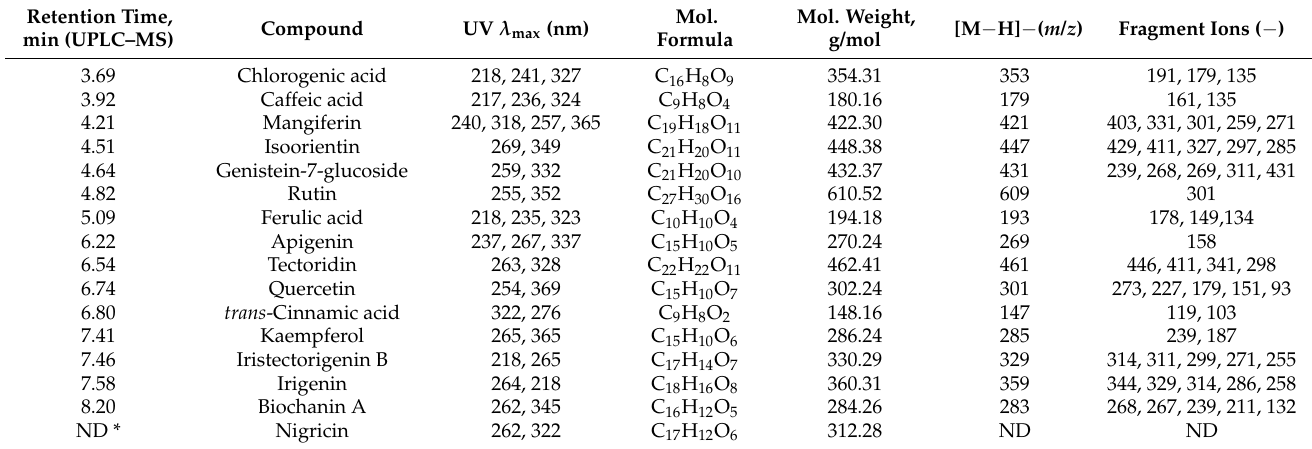
Table 2. Chromatographic, UV, and mass spectroscopic data of the reference